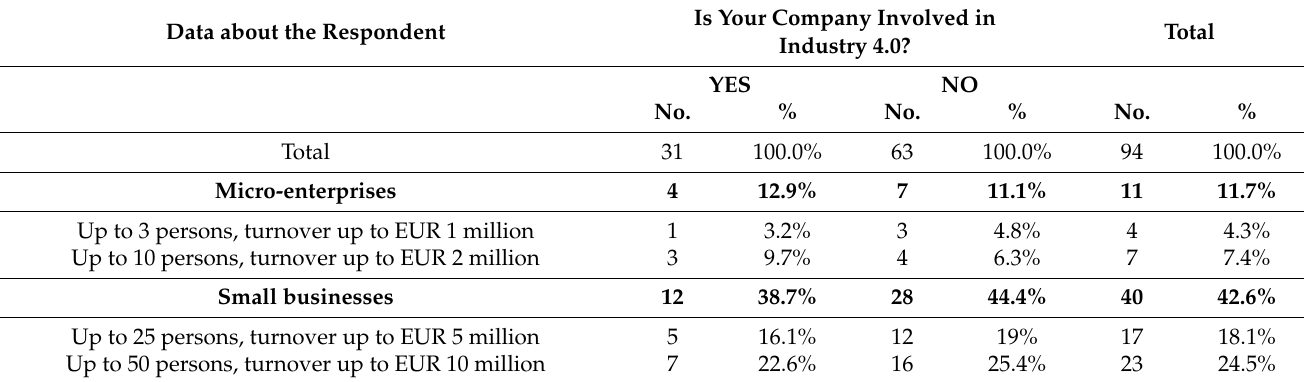
Table 3. Number of respondents by size category of the